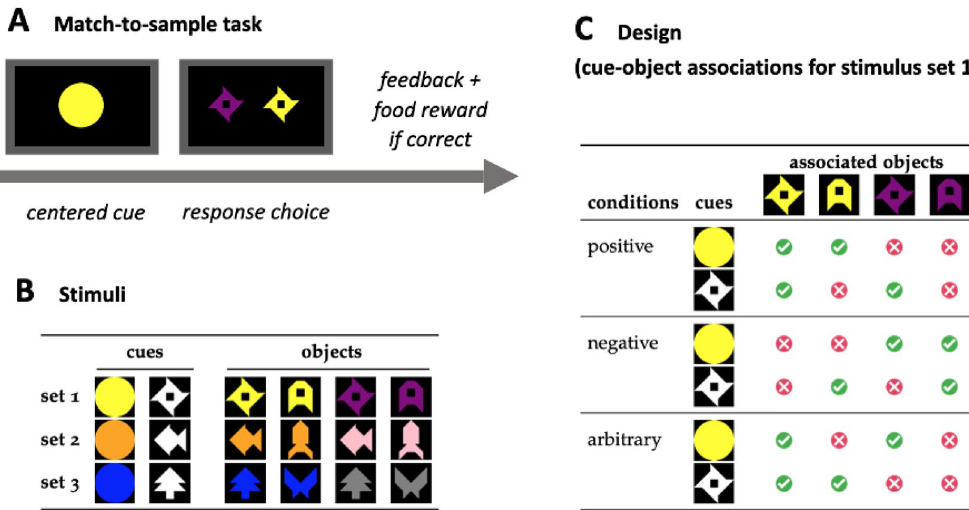
Figure 1. Task and experimental design (Experiment 1). ( A ) Baboons were taught cue-object associations in a matching-to-sample task that consisted of a series of trials in which a cue (e.g., a yellow circle) was presented centrally before baboons could choose which of two objects was associated with it. ( B ) In consecutive stages, baboons were exposed to different stimuli sets. ( C ) For each stimulus set, a baboon learned associations between cues and objects based on conditions (positive, negative, or